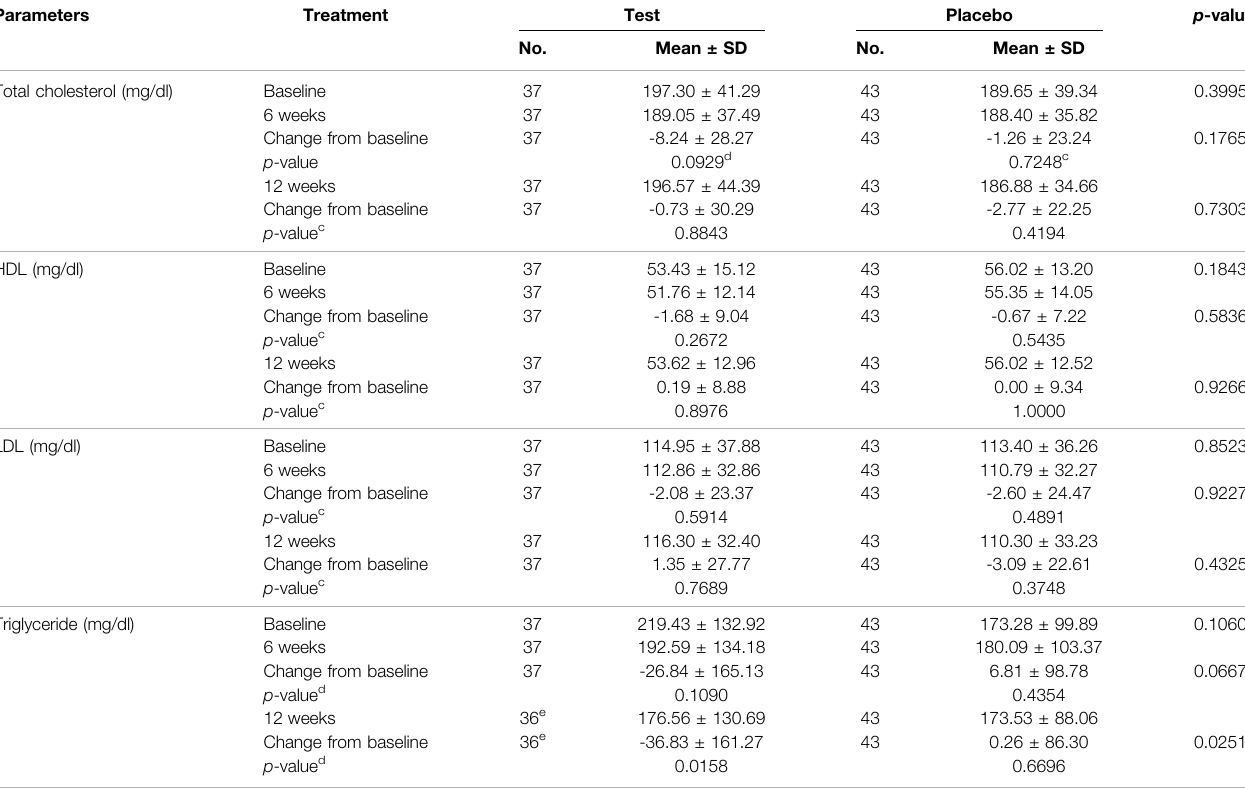
TABLE 6 | Levels of total cholesterol, HDL, LDL, and triglycerides based on visits (PP Set). Parameters Treatment